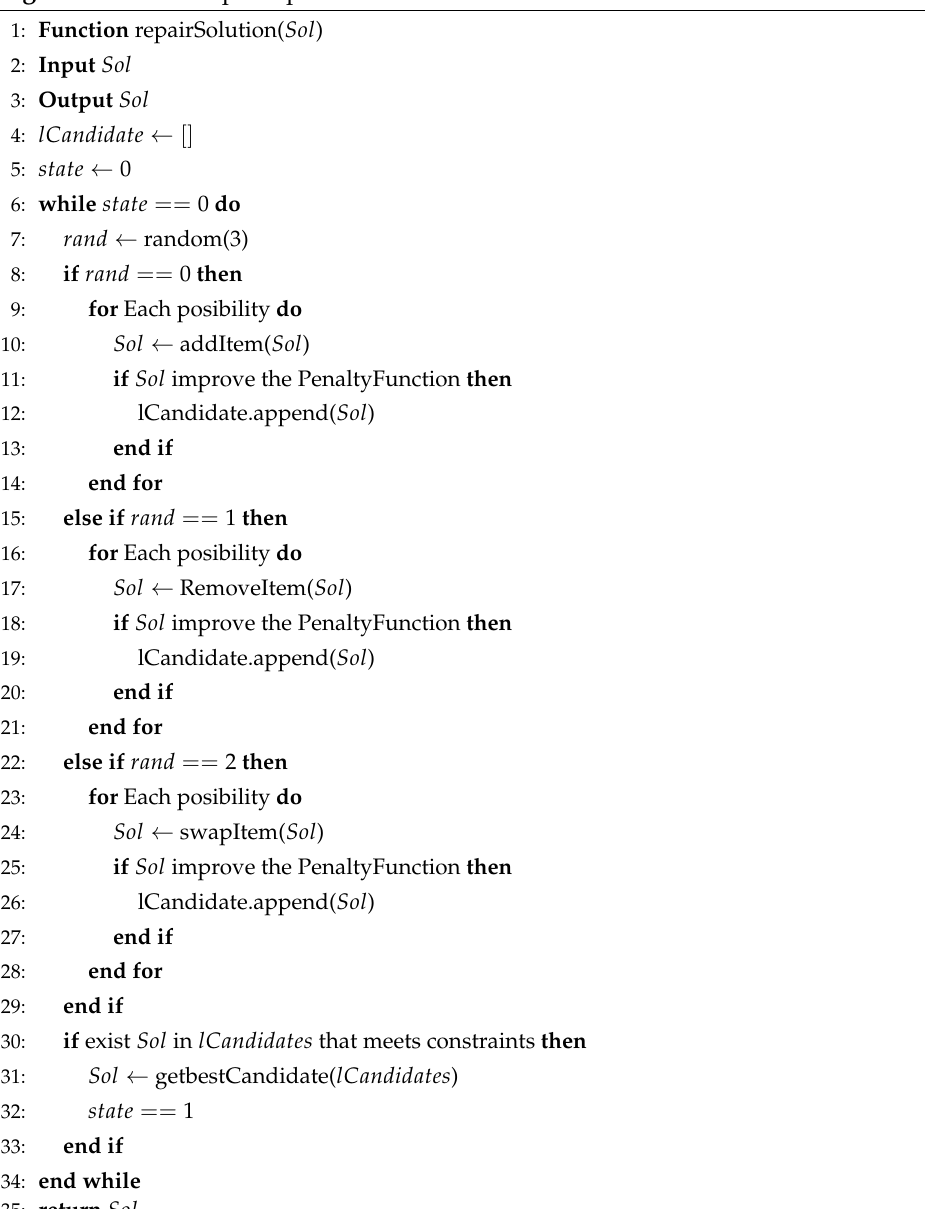
Algorithm 3 : The repair